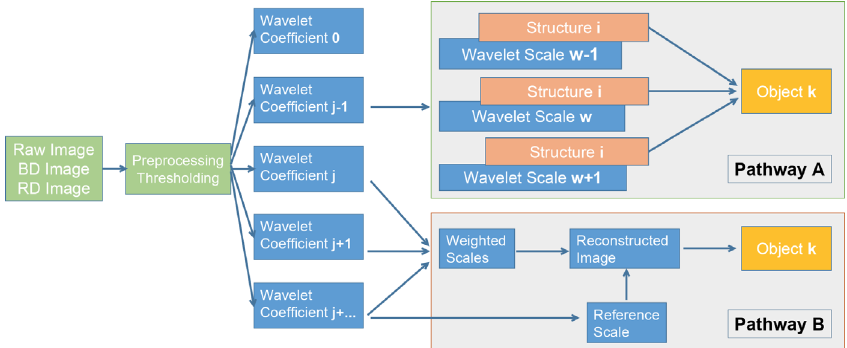
Fig. 2. Image processing stages with Wavetrack software. Base Difference, Running Difference, or RAW image is used as an input. After pre- processing, the image is decomposed with à trous wavelet transform, and objects are labeled depending on the wavelet scales